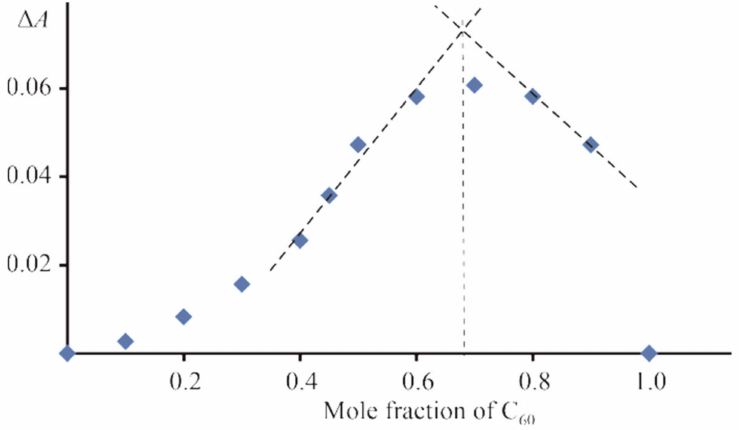
Figure 2. Job’s plot for CoTTP–C 60 system in toluene; in Job’s experiment, the concentration of CoTTP and C 60 are continuously varied in the concentration range from 1.06 × 10 − 6 M to 1.06 × 10 − 5